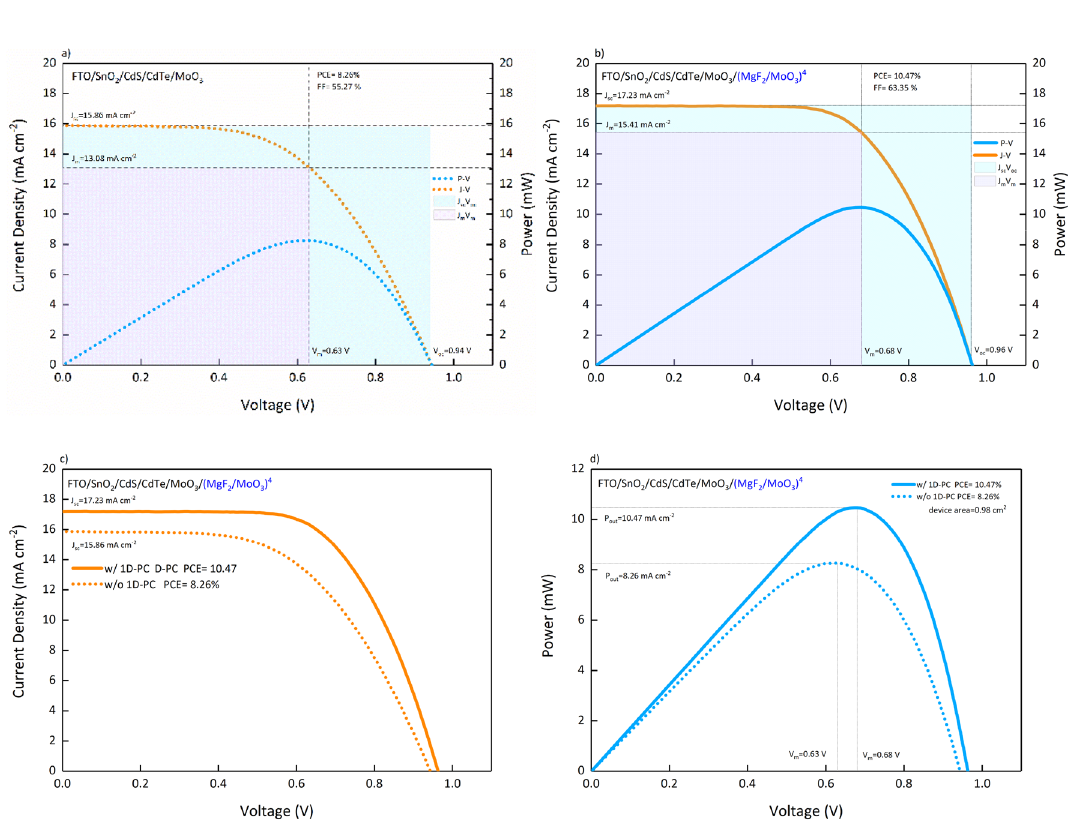
2 /CdS/CdTe/MoO 3 and ( b ) FTO/SnO